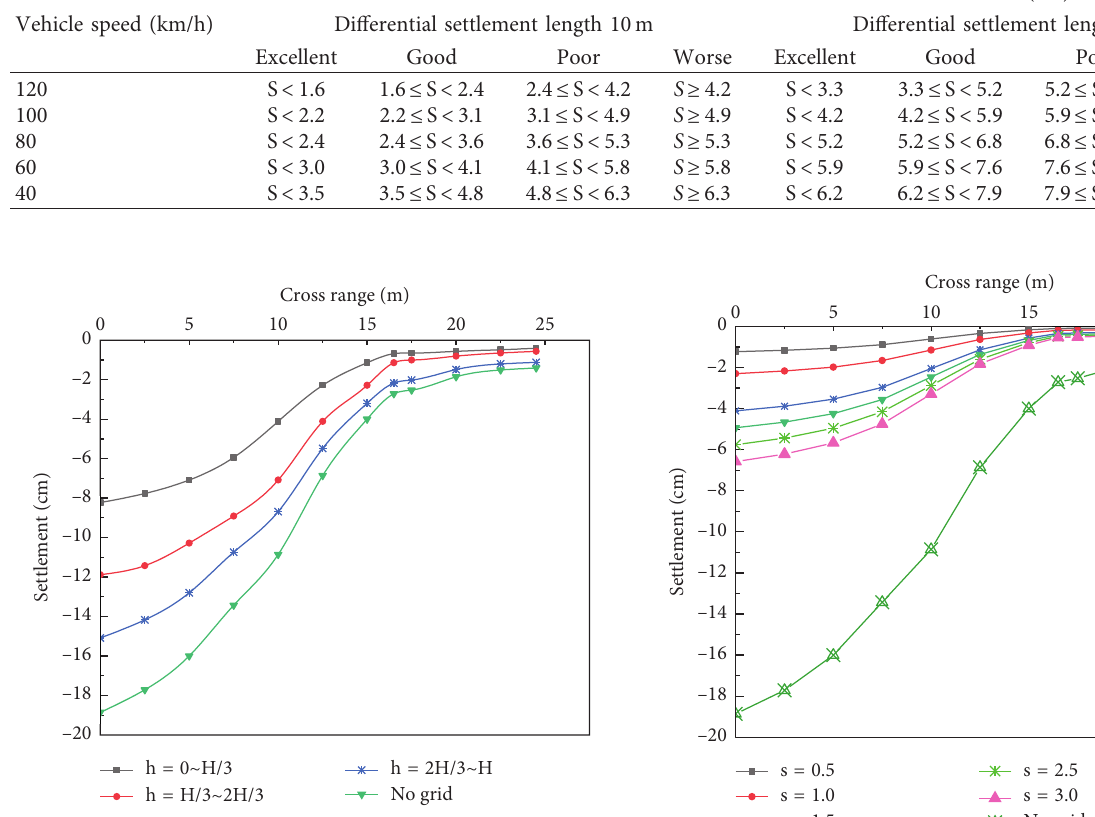
Figure 7: Settlement of the top surface of the subgrade at different grid laying locations.